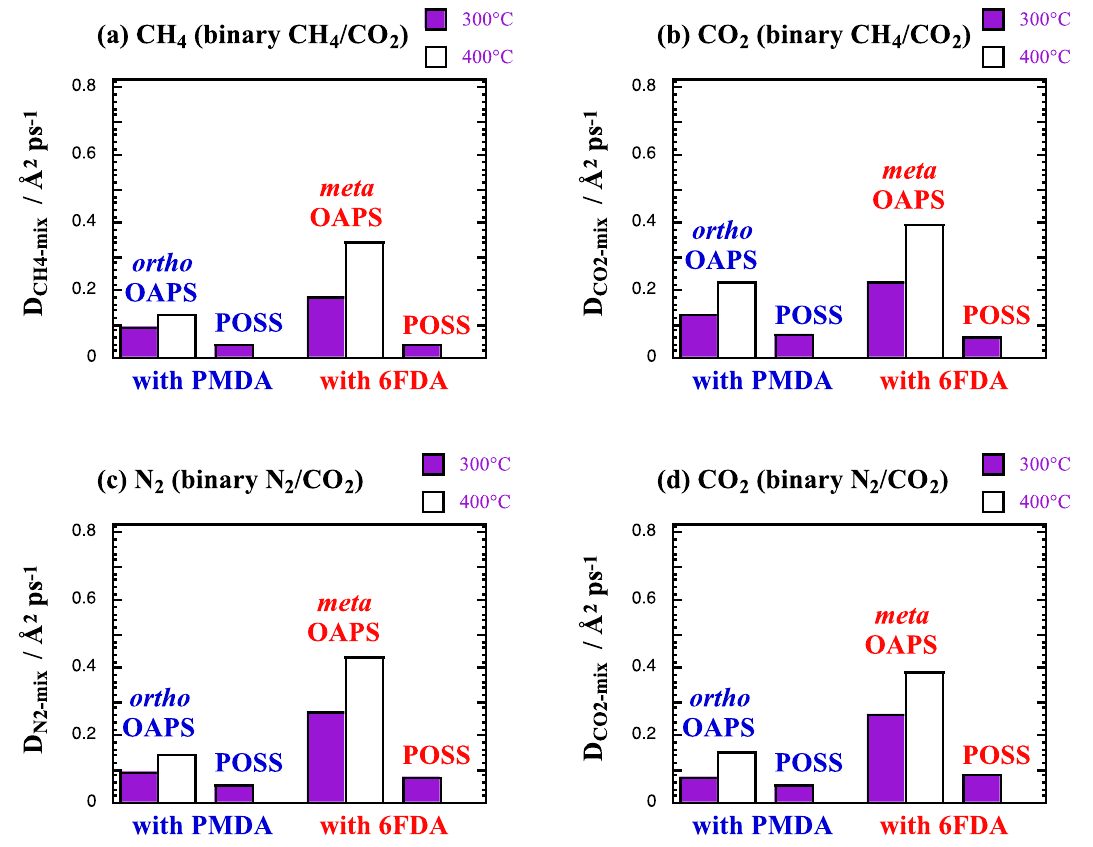
Figure 11. Mixed-gas diffusion coefficients D gas-mix at 300 °C and 400 °C in the selected polyOAPS/POSS-imides for ( a , b ) CH 4 and CO 2 from the 90%/10% CH 4 /CO 2 mixture and ( c , d ) N 2 and CO 2 from the 90%/10% N 2 /CO 2 mixture at 60 bar. The scale is 25% of that in Figure 6. The maximum standard error is 0.03 Å 2 ps −1 .